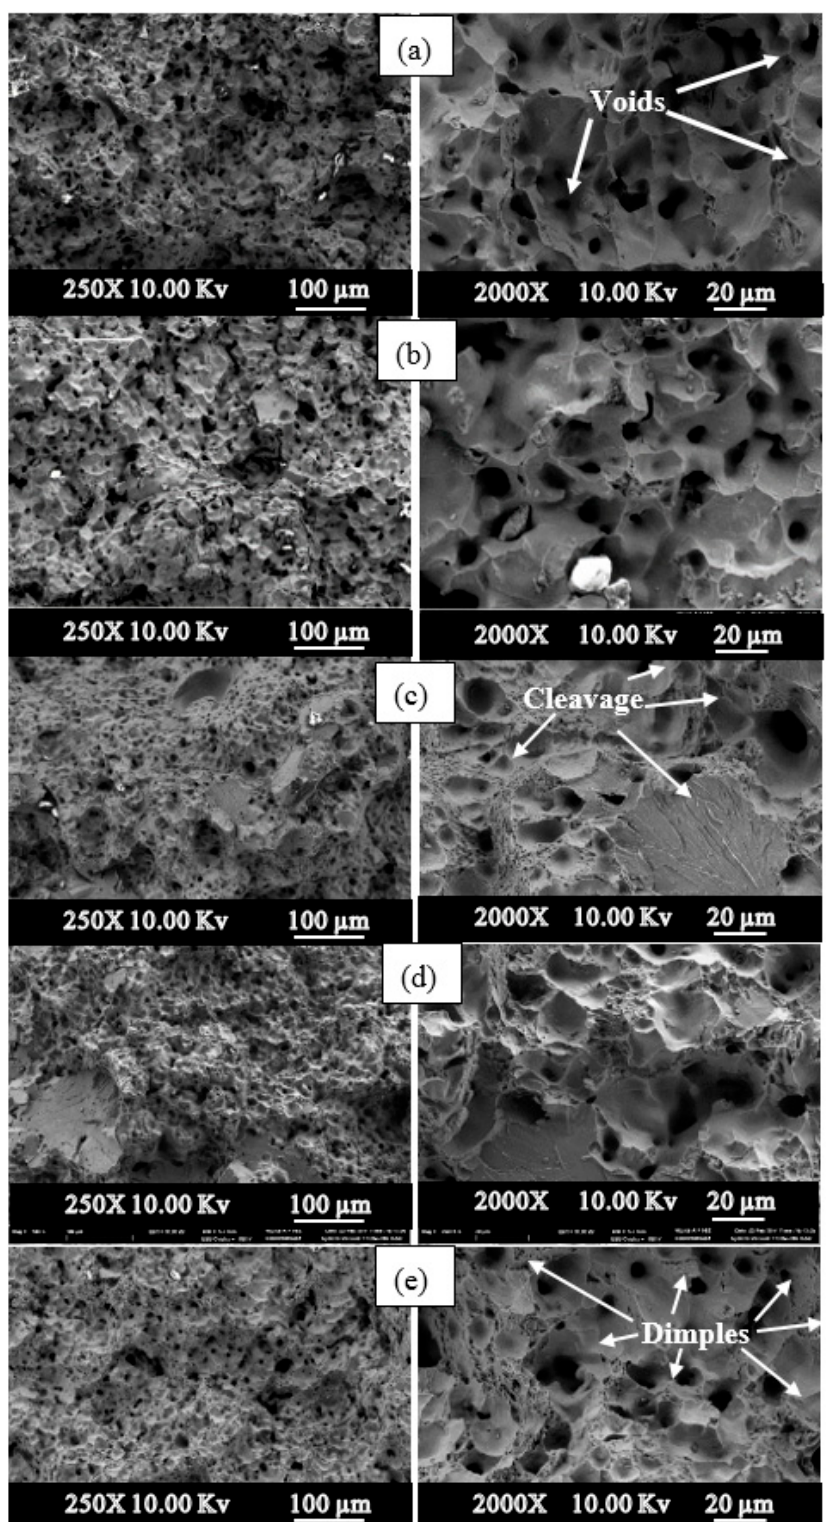
Figure 12. Fracture surfaces of PM steels (250 × –2000 × ). ( a ) Alloy 1, ( b ) Alloy 2, ( c ) Alloy 4, ( d ) Alloy 5, ( e ) Alloy 8).